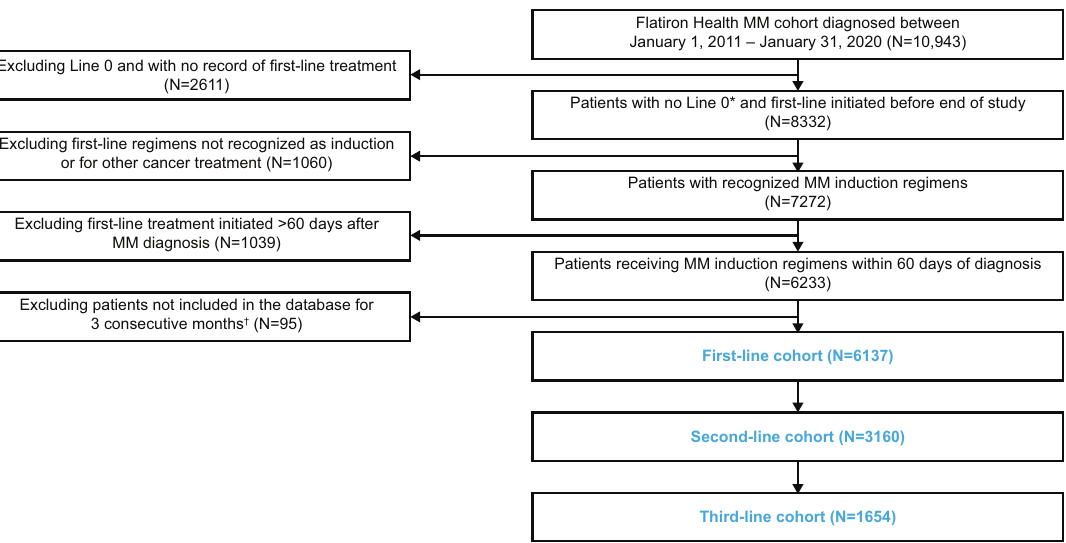
Fig. 1 Patient disposition. *Patients who received MM treatment (as captured through unstructured data) >30 days before the start of structured activity within the Flatiron Health network, for whom therapy data may be missing. † To ensure that all included patients have been in the database a suf fi cient duration of time to account for lags in the abstraction of data elements or data linkages to external data sources. L0 line 0, MM multiple